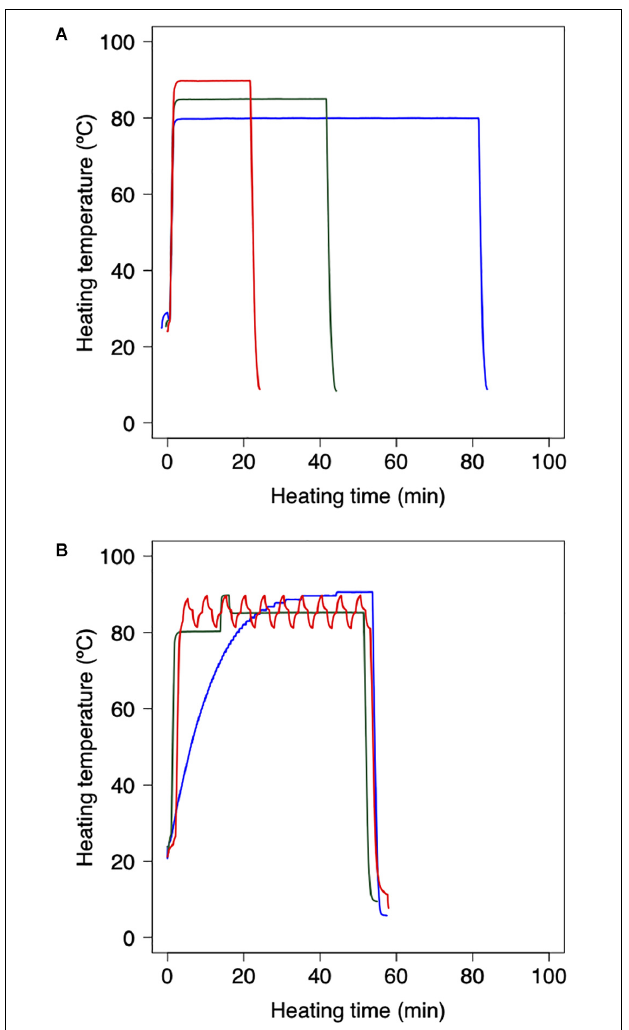
FIGURE 1 | Example of heating protocol using thermal cycler. (A) Temperature profiles of inactivation trials for model fitting dataset. 80 min heating at 80 ◦ C (red), 35 min heating at 85 ◦ C (green), and 18 min heating at 90 ◦ C (blue). Preheating is conducted for 30 s at 25 ◦ C to standardize the initial temperature across trials. (B) Temperature profiles of inactivation trials for model validation dataset. Slow come-up (blue), bumpy (green) and waving (red) temperature profiles. Following the heating process, the 96-PCR microplates are immediately chilled at 4 ◦